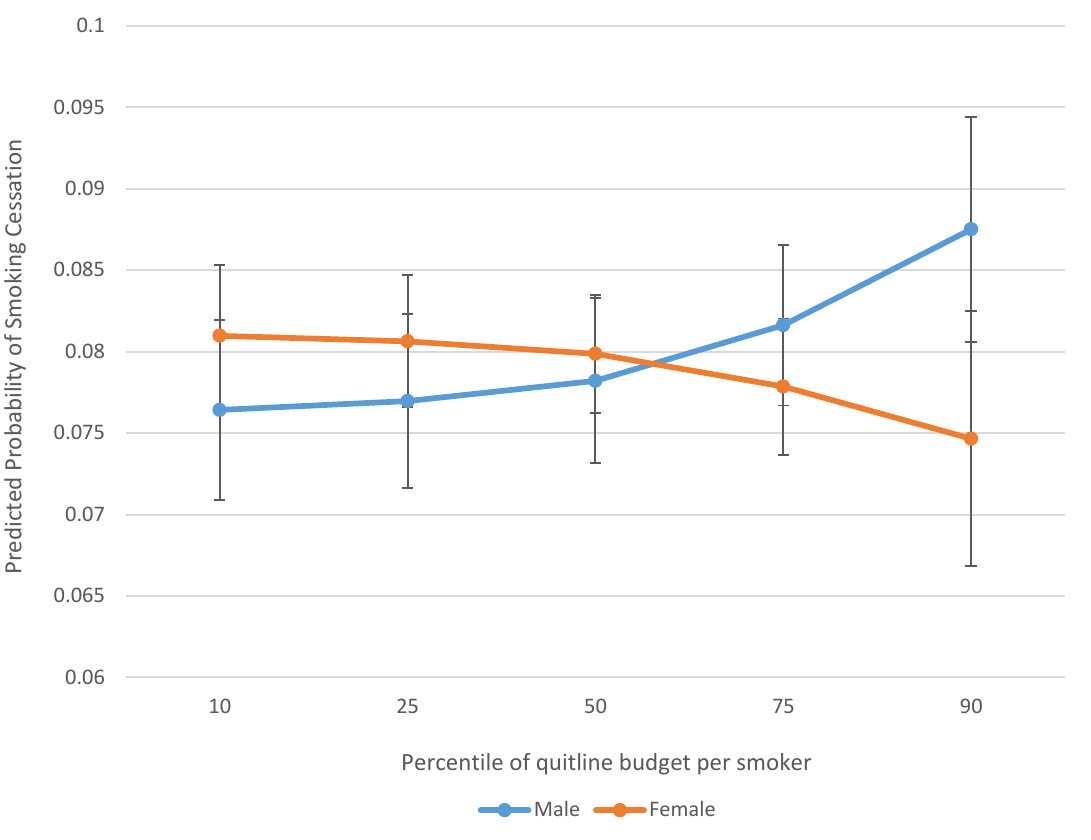
Figure 1. Predicted probability of 90-day smoking cessation associated with quitline budget per smoker, by gender.